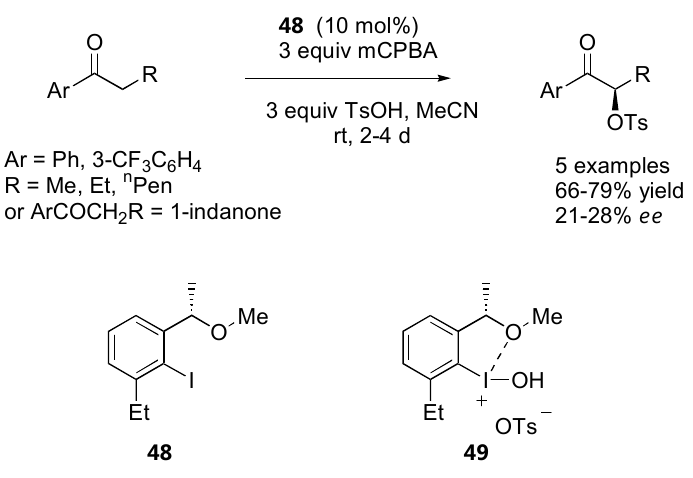
Figure 38.  -Oxysulfonation of aromatic ketones catalyzed by iodoarenes